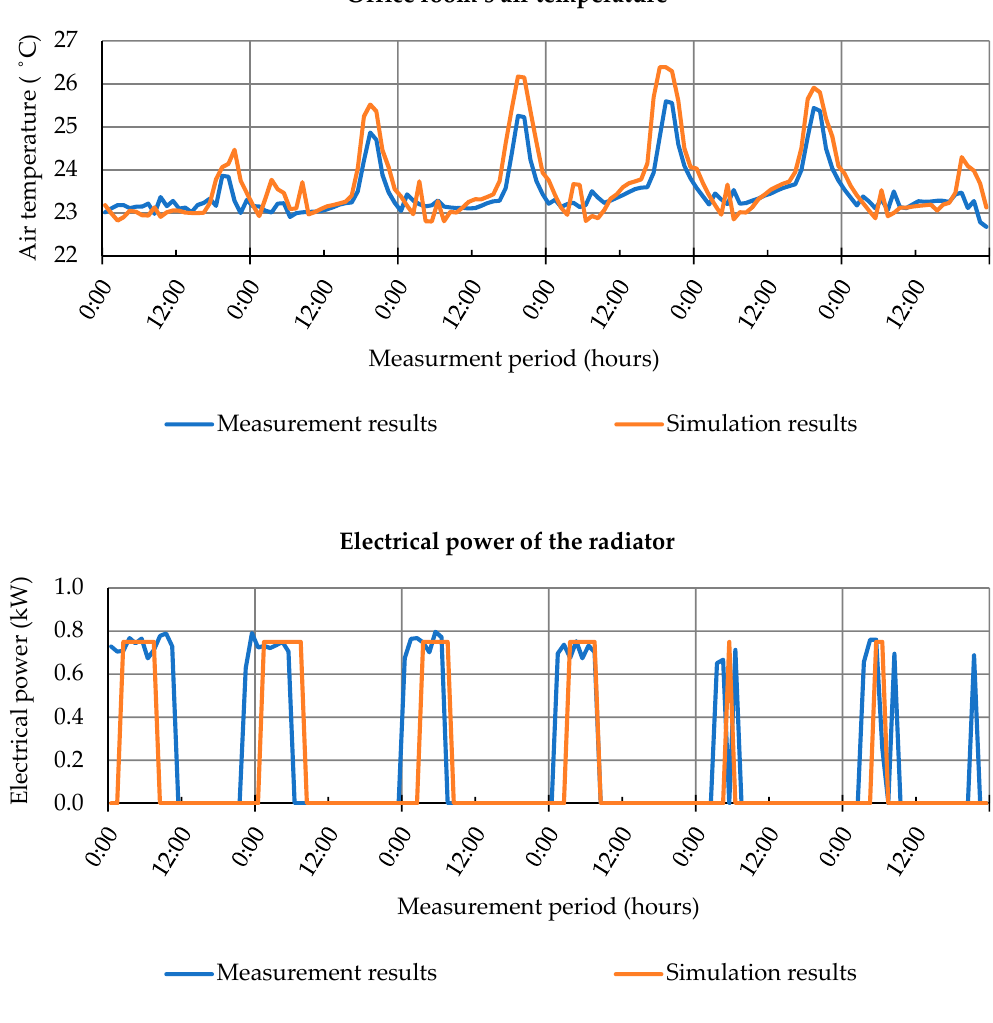
Figure 4. O ffi ce room’s air temperature ( ◦ C) and electrical power of the radiator (kW) during the Figure 4. Office room’s air temperature (°C) and electrical power of the radiator (kW) during the measurements period (12th–17th May) based on both measurement and simulation measurements period (12th–17th May) based on both measurement and simulation results